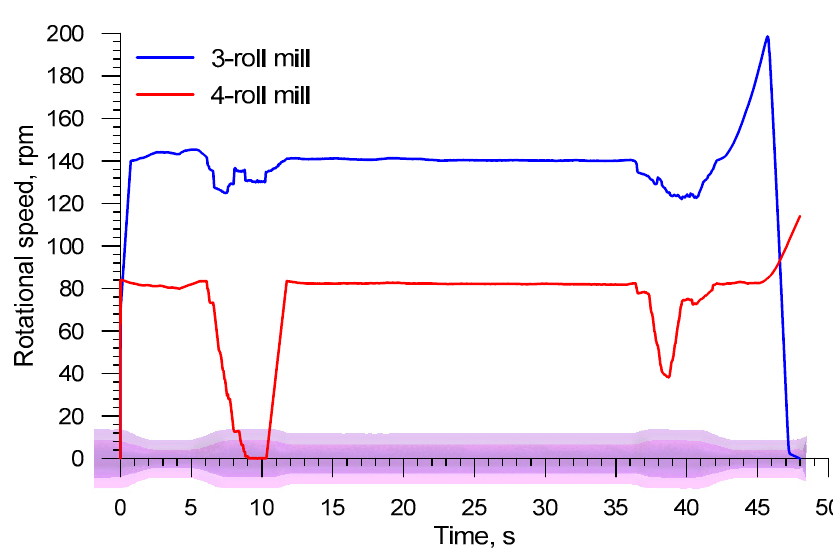
Figure 20. Rotational speed of the workpiece in skew rolling hollow axles in 3- and 4-roll mills. Table 2. Energy required to form hollow axles.